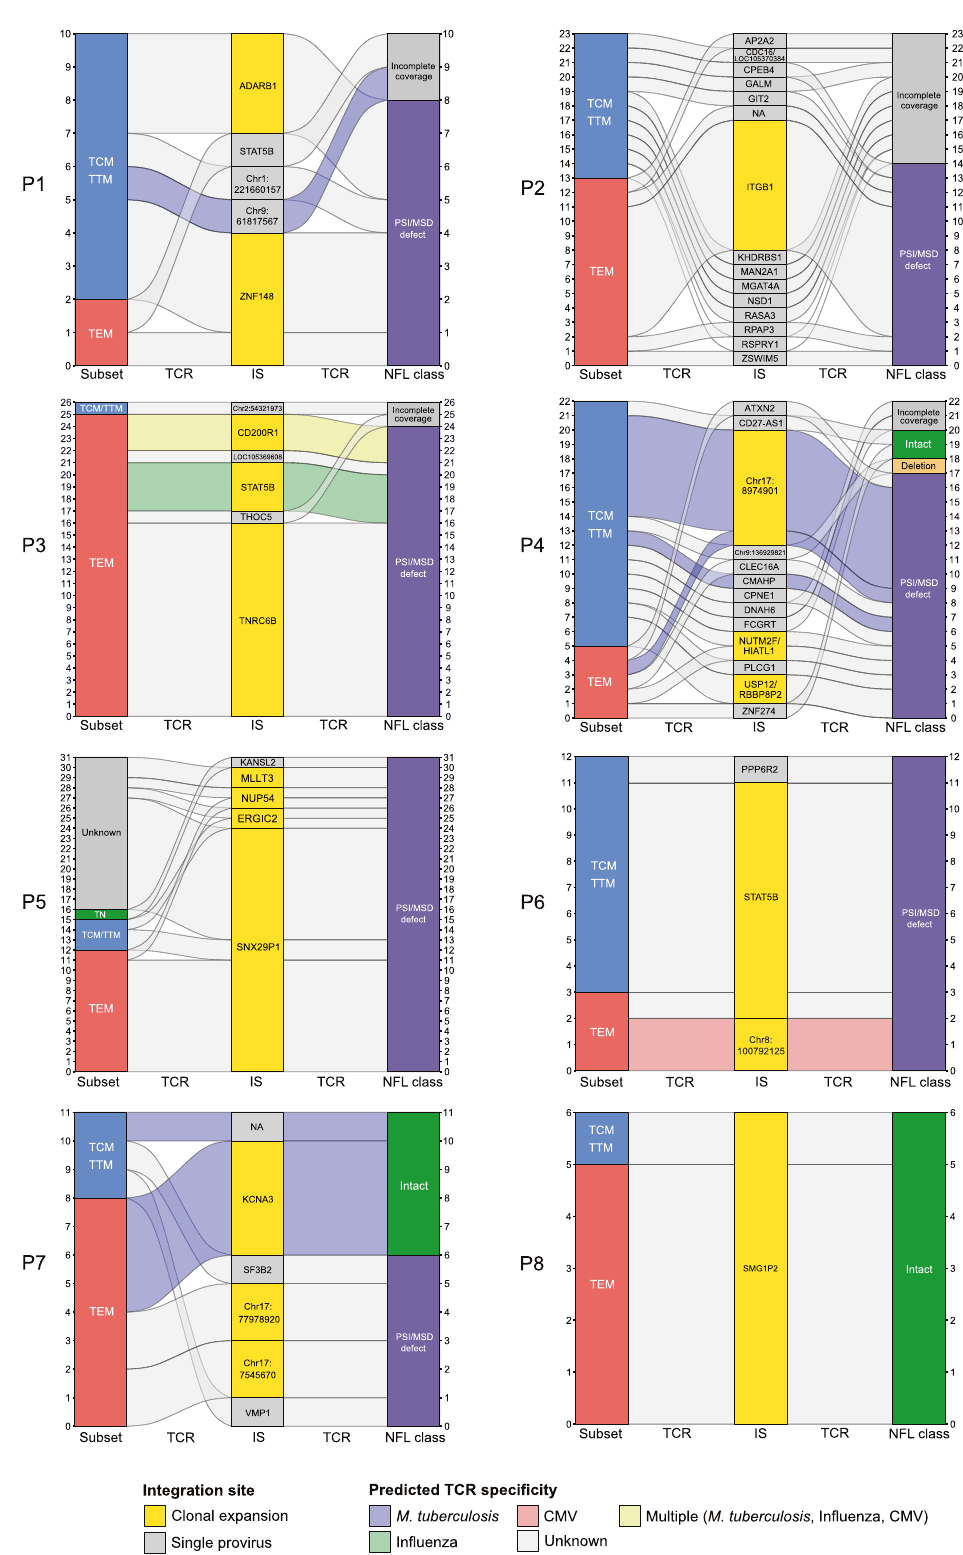
Fig. 3 Predicted TCR speci fi city of single p24-producing cells. Alluvial plots showing the memory phenotype of the host cell, the IS and the NFL class for each p24-producing cell from n = 8 ART-treated individuals. Single p24 + sorted cells are represented on the y -axis of each plot. Alluvials connecting the different categories are colored according to predicted TCR speci fi city. Only time points on ART are represented on this fi gure. IS integration site, TCR T cell receptor, NFL near full-length, TN naïve T cell, TCM central memory T cell, TTM transitional memory T cell, TEM effector memory T